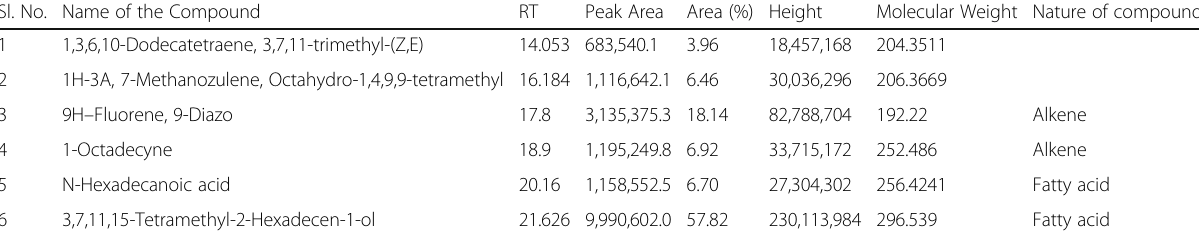
Table 6 Volatile compounds identified in the methanolic leaf extract of Bidens pilosa by GC-MS Sl. No. Name of the Compound RT Peak Area Area (%) Height Molecular Weight Nature of